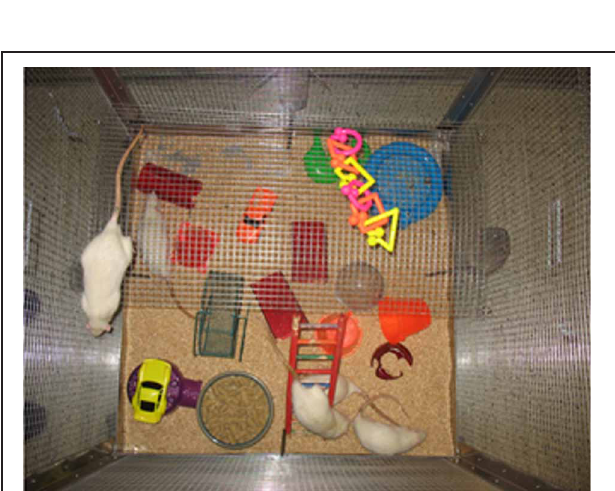
FIGURE 2 | Enriched housing condition (EC group). The EC group was housed in large wire mesh cages (1m 3 ) with levels and access to running wheels and toys, replaced twice